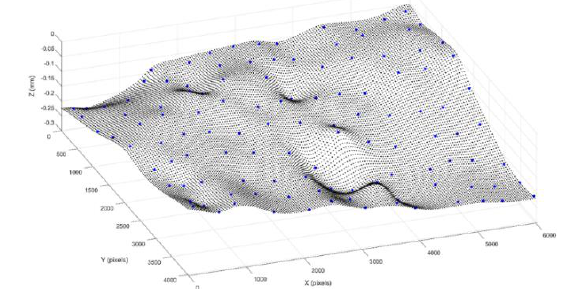
Figure 10. 3D surface fitted to key points over the image